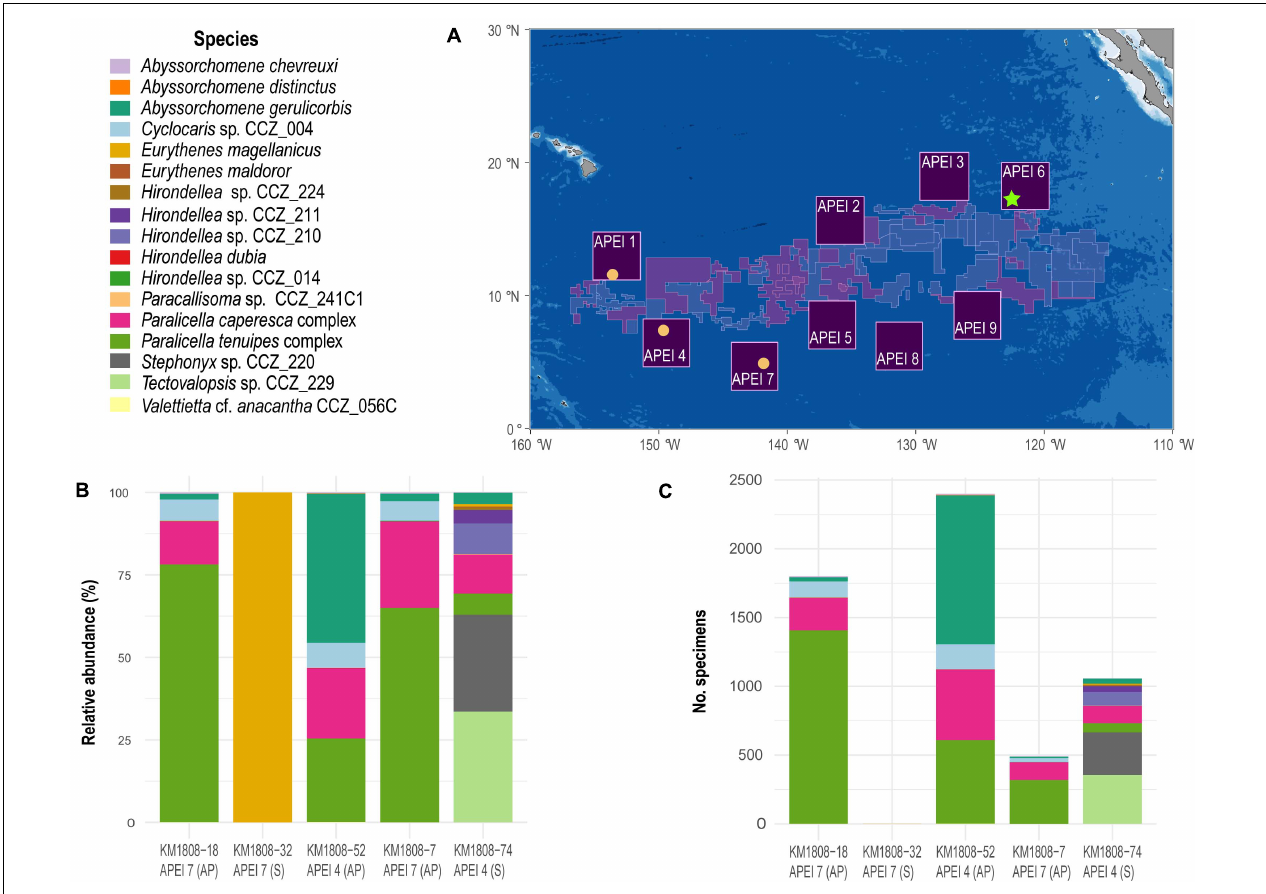
FIGURE 1 | Map of the Clarion-Clipperton Zone indicating the Areas of Particular Environmental Interest [APEIs; (A) ]. Yellow circles indicate the sites where baited-traps were deployed during the DeepCCZ expedition, with bar plots indicating the relative abundance (B) and total number of specimens collected (C) of each of the different morphospecies of scavenging amphipod recovered at each site. During deployment KM1808-32 on APEI 7, only a single specimen was recovered. The green star indicates the site where the baited trap was deployed during the JC120 expedition, and from which only a few specimens were included in this study. S, seamount, AP, abyssal